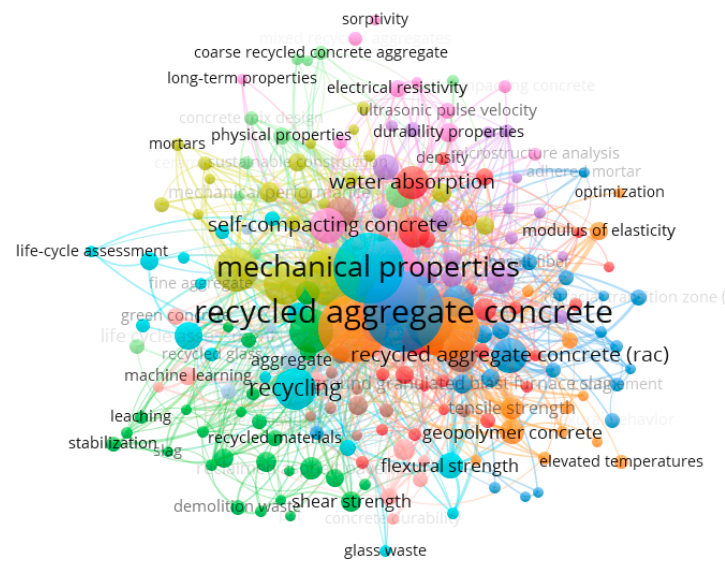
Figure 1. Bibliometrics analysis from [23].